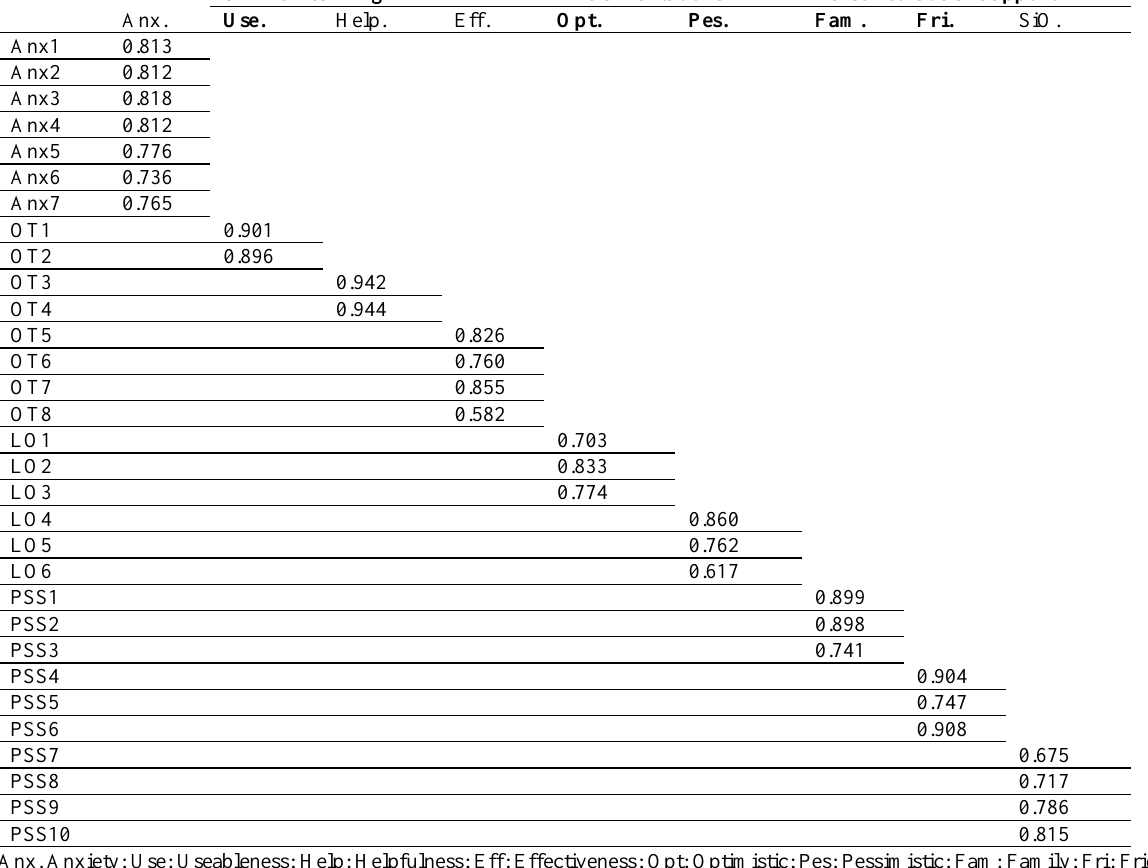
Table 1: Confirmatory Factor Analysis Results of the Scales Online Anx.